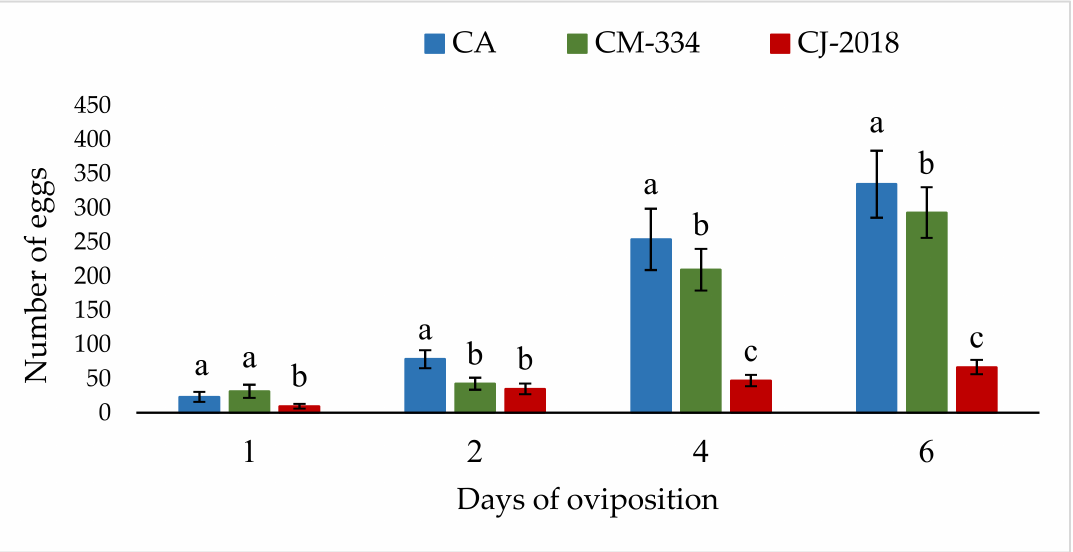
Figure 1. Number of eggs laid by females of Bactericera cockerelli in three varieties of pepper, on different days of oviposition. CA: chili pepper ‘Arbol’, CM-334: ‘Criollo de Morelos 334’, CJ-2018: ‘Criollo de Jojutla 2018’. Each point represents the average of 10 repetitions corresponding to two repetitions of the test. Values with different letters each time were significantly different (Tukey test p <